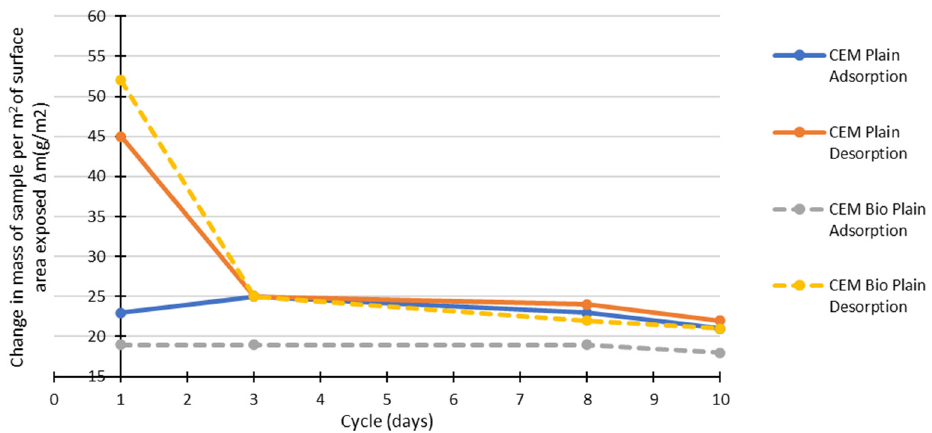
Figure 17. Adsorption and desorption change during 10 cycles for cement-based mortars with/without biostabiliser (bio).